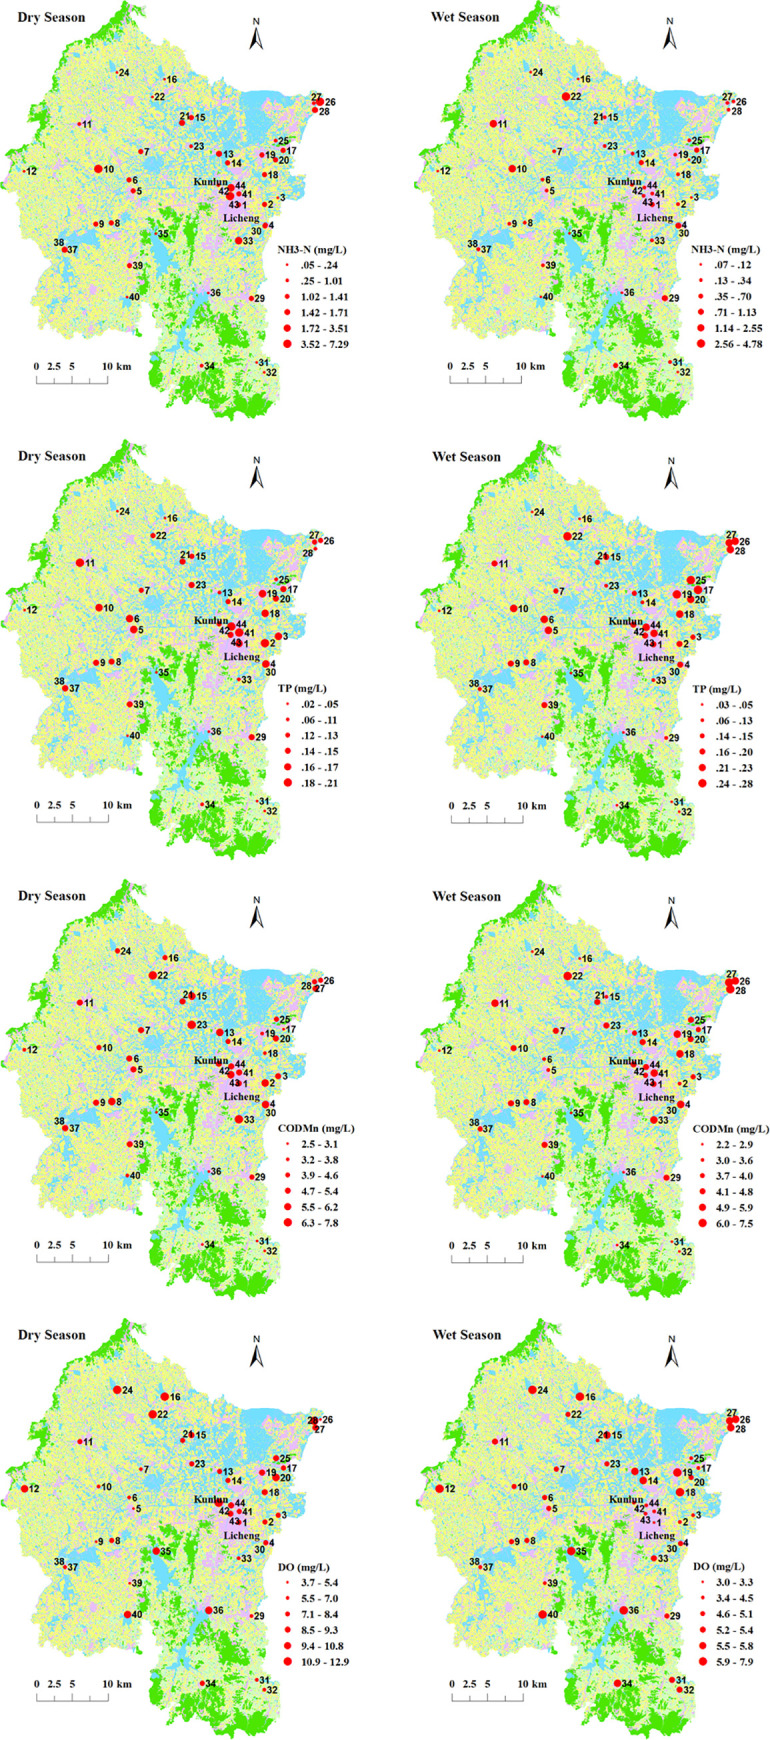
Spatial differences in seasonal WQPs.